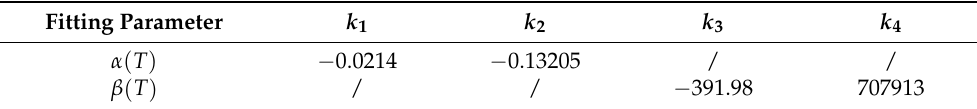
Figure 2. Measured operation times during P/E cycling at different temperatures: ( a ) erase time ( t erase ) and ( b ) program time ( t prog ). t erase depends on the temperature, while t prog depends on both the temperature and P/E cycles, which agreed well with the simulation curves in the blocks with higher than 100 P/E cycles. Table 1. The values of fitting parameters in α ( T ) and β ( T )